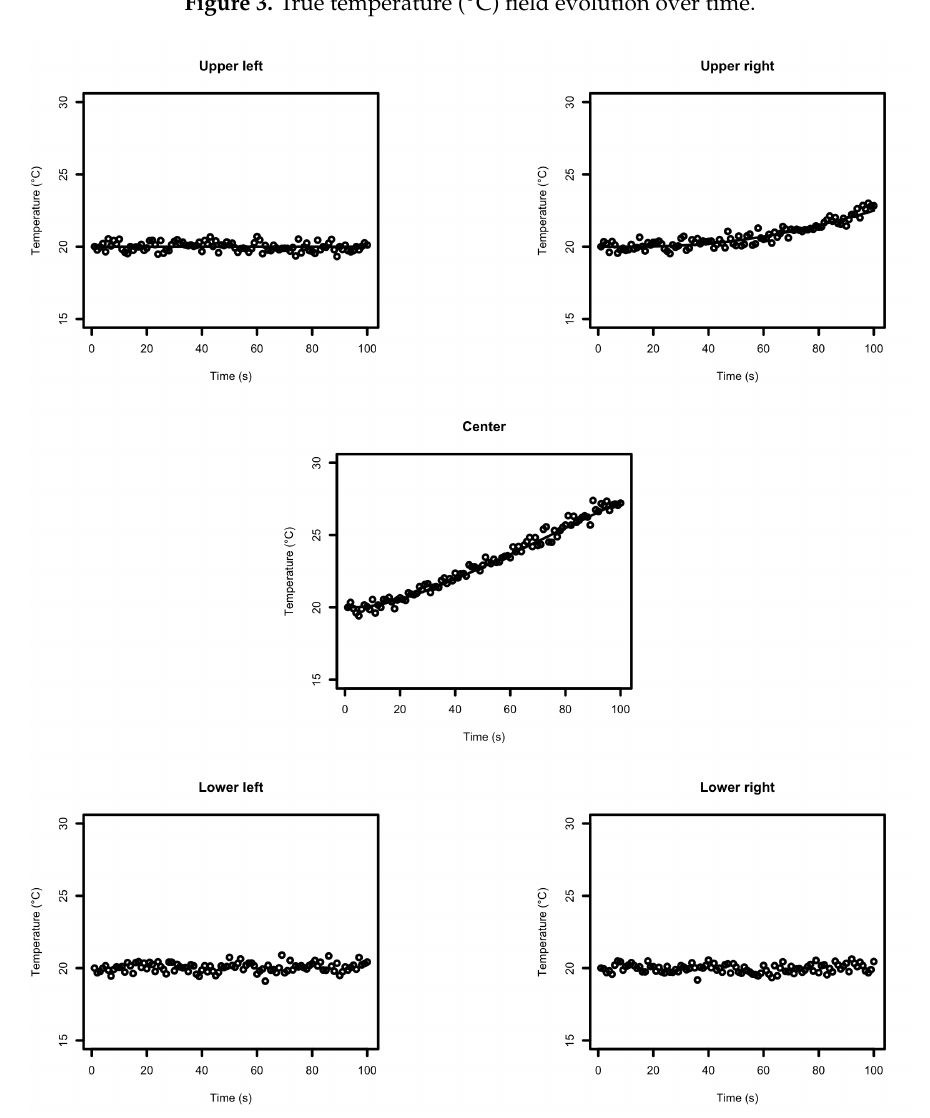
Figure 3. True temperature ( ◦ C) field evolution over time.